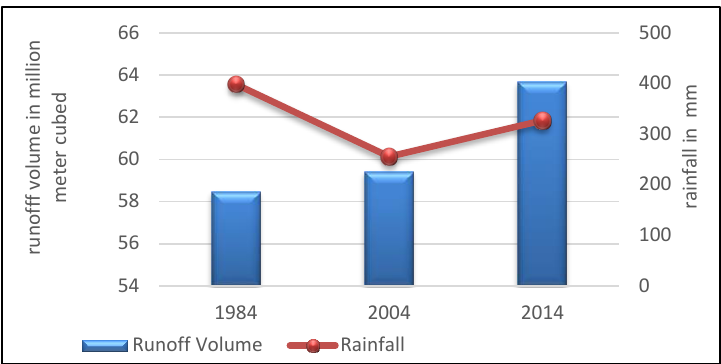
Figure 8. Average rainfall depth and runoff volume from 1984 to 2014.